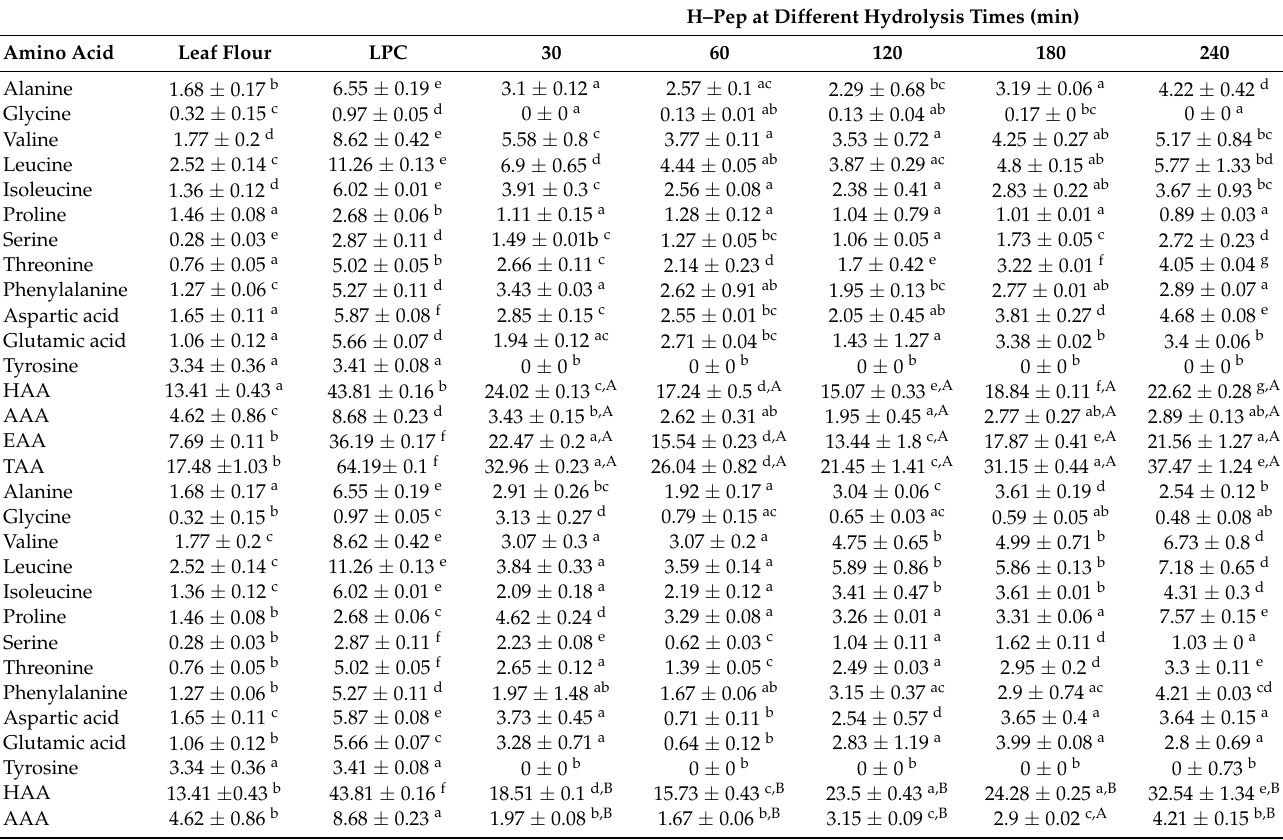
Table 1. Amino acids profile (g/100 g protein) of LPC and protein hydrolysates obtained after treatment with pepsin and